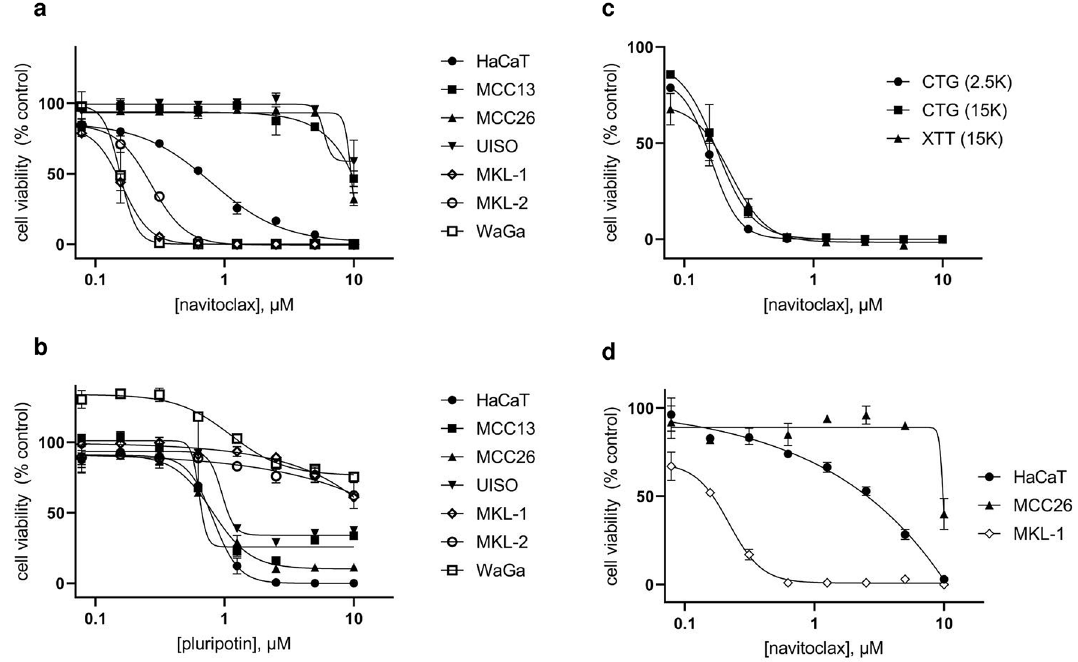
Figure 1. Effects of control compounds on cell survival. The indicated cell lines (2500 cells/well, 384-well plates) were incubated for three days with ( a ) navitoclax (ABT-263), or ( b ) pluripotin (SC-1) and cell viability was estimated using CellTiterGlo (CTG). In a separate experiment, ( c ) MKL-1 cells at 2500 or 15,000 cells/well as indicated were treated with navitoclax and cell viability was estimated with XTT or CTG as indicated. ( d ) XTT assessment of HACAT (2500 cells/well), MCC26 (2500), or MKL-1 (15,000) after navitoclax treatment. In all cases, values were normalized to DMSO controls for each cell line. Error bars represent sd (n =